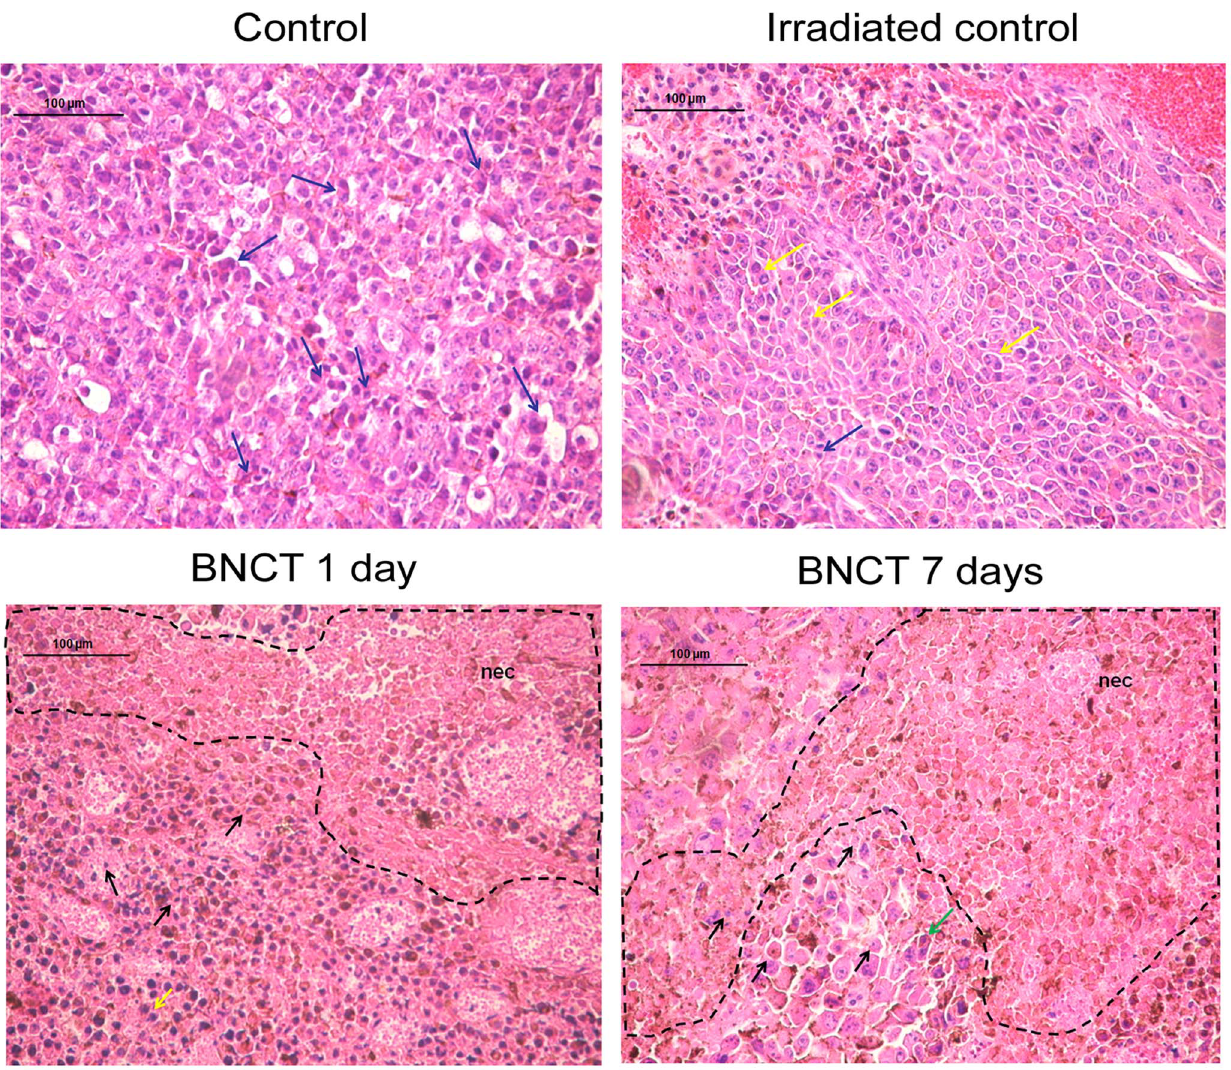
Figure 7. Hematoxylin and eosin-stained sections of malignant melanoma in control, irradiated control, BNCT 1 and BNCT 7 days groups. In the control and irradiated groups, malignant melanoma cells were preserved and composed of large cells with atypical nuclei and abundant cytoplasm. Normal mitosis (blue arrows) and aberrant mitosis (yellow arrows) were both observed. Necrosis was absent in both groups of melanoma. By contrast, extensive necrosis (nec), pycnotic nuclei (black arrows) and acidophilic cytoplasm (green arrows) were present in the malignant melanoma of BNCT 1 and BNCT 7 day groups. Furthermore, the BNCT groups also presented aberrant mitosis.